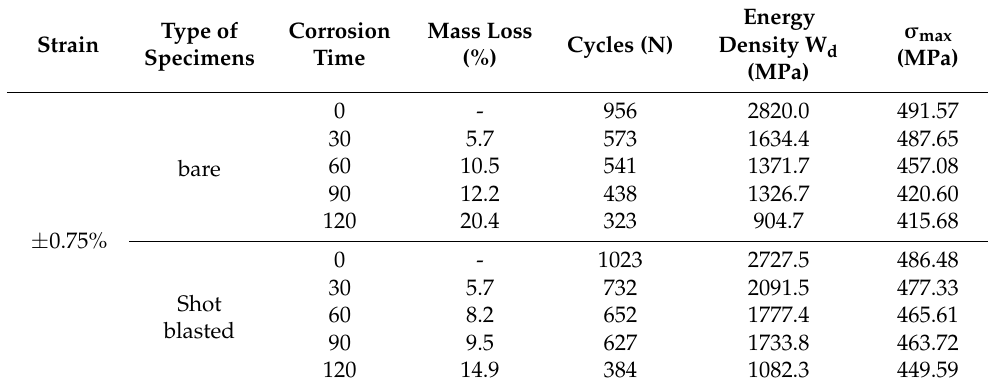
Table 8. Results of LCF tests with free length 6Ø conducted on bare and shot blasted specimens (in non-corroded and corroded conditions) for imposed deformation ± 0.75%. Type Strain